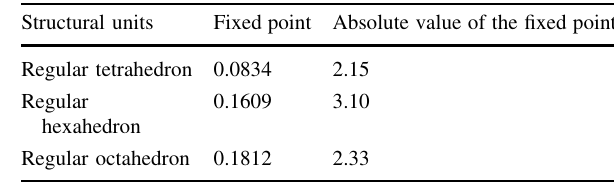
The slope of this point on the curve has an absolute value of 2.33. 0.1812